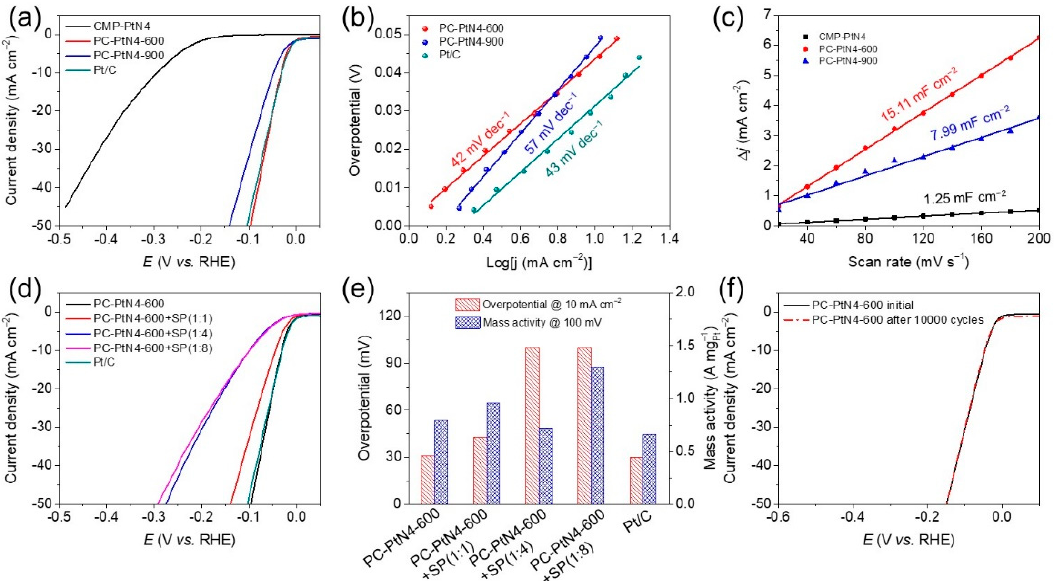
Figure 5. Electrocatalytic performance of the samples in 0.5 M H 2 SO 4 under N 2 at room temperature. ( a ) hydrogen evolution reaction (HER) polarization curves, ( b ) Tafel slope plots acquired from polarization curves, and ( c ) capacitive current at 0.35 V as the function of scan rate of CMP-PtN4, Pt / C and PC-PtN4-T. ( d ) HER polarization curves, ( e ) overpotential at 10 mA cm − 2 and mass activity at 100 mV of PC-PtN4-600 and Super P carbon based composites. ( f ) Stability test of PC-PtN4-600. The polarization curves were recorded initially and after 10,000 potential cycles between − 0.15 and + 0.15 V (vs. RHE) at 100 mV s − 1 .